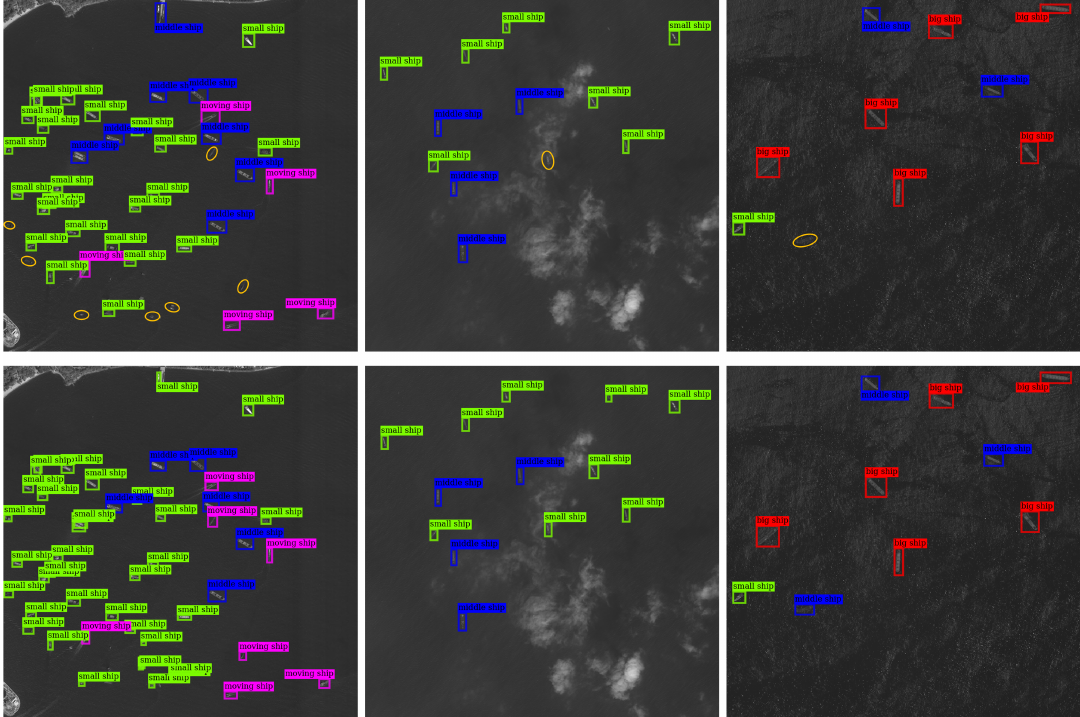
Figure 7. Detection results of YOLOv3 (the first row) and our ImYOLOv3 (the second row). Yellow circles denote missing